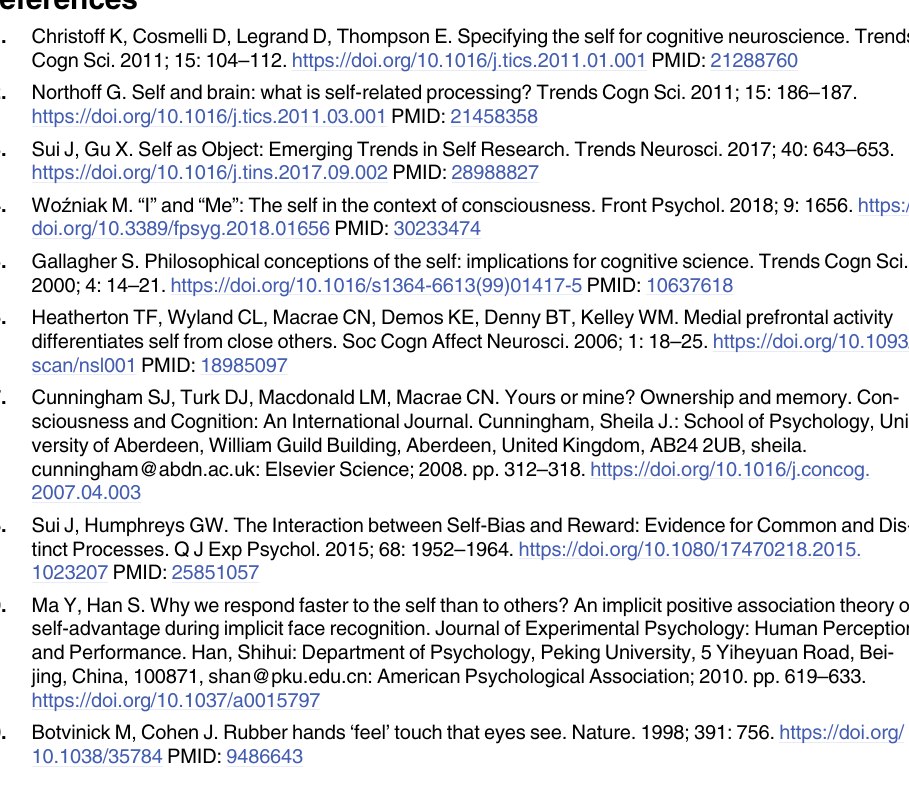
S2 Table. Results of the linear mixed effects model to test agency and feedback as predic- tors of rating (sense of agency) for patients with primary generalized anxiety disorder (GAD) and major depressive disorder (MDD), which compromised the depression and anxiety disorder (DA) group. S3 Table. Results of the linear mixed effects model to test agency (self, ambiguous and computer) and feedback (positive-win and negative-loss) as predictors of rating (sense of agency) for the online